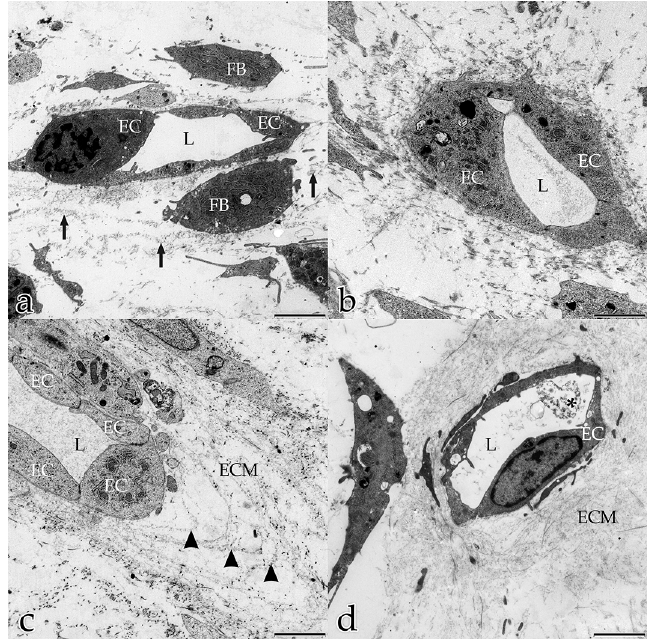
Figure 6. Coculture of ECs with FBs after 5 days ( a ); 10 days ( b ); 14 days ( c ); 20 days ( d ). EC tubular structures with lumina (L) in transverse sections: ( a ) the ECM presents as a randomly orientated mesh of fibrous and electron-dense molecules (arrows); ( b ) the ECM is most dense in the periphery of the endothelial tubular structures; ( c ) lamellae of fine fibrils surround the endothelial tubes (arrowheads) and build up a scaffolding network between the cells; ( d ) densely organized ECM, with a close resemblance to in vivo loose connective tissue, fill nearly all intercellular spaces. Vacuoles and parts of cellular membranes lie within the tubule’s lumen (asterisk). ( a – d ) Bar: 2.500 nm.